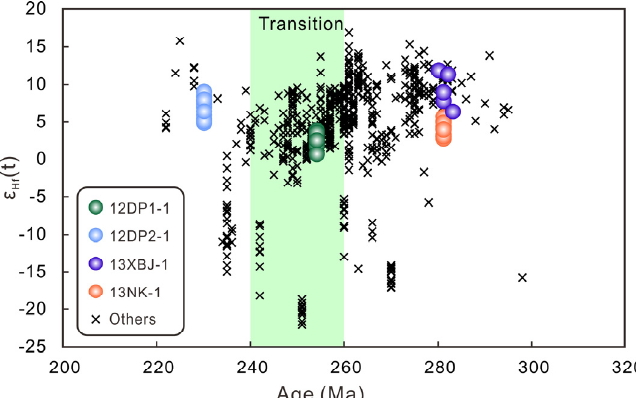
Figure 9. ε Hf (t) values versus ages from the Permian to the Triassic magmatic rocks along the CYS. The arrows outline the trend of zircon Hf isotopic evolution with time. The decreasing arrow illustrates an evolved trend, whereas the increasing arrow indicates a depleted trend. The green field represents the tectonic transitional period with a considerable isotopic variation. Data for other coeval magmatic rocks are from the works in [36,37,40,42–46].